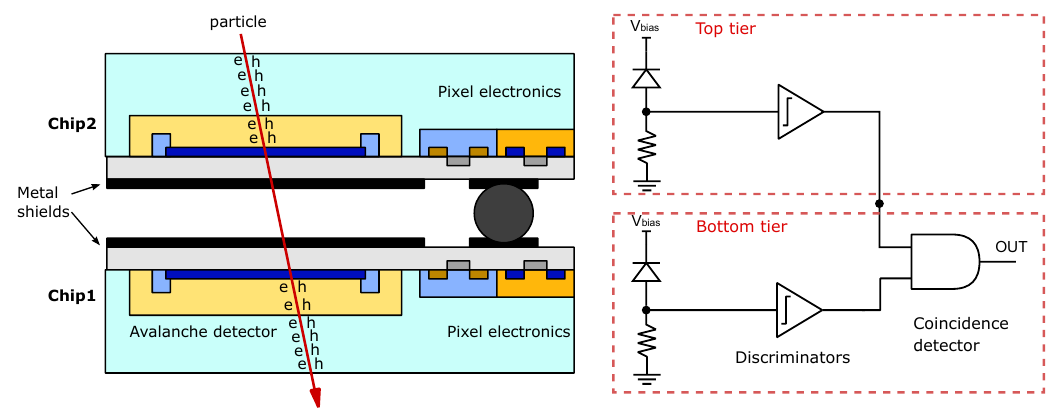
Figure 6. Cross-section of a 3D-PDC with SPAD on both layer for DCR mitigation using coincidence detection. (Illustration courtesy of Lucio Pancheri, University of